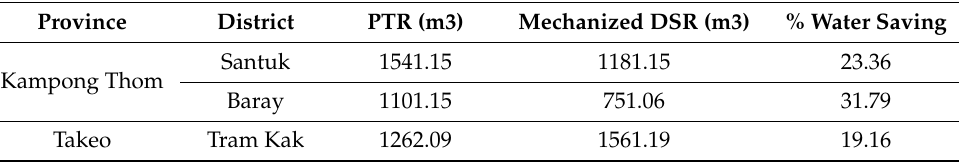
Table 1. Water saving under mechanized DSR compared to PTR at Kampong Thom and Takeo sites,